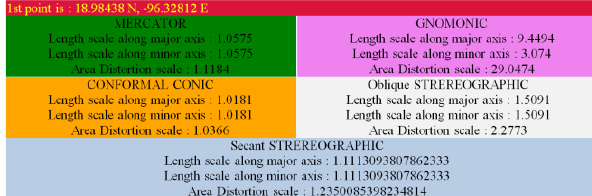
Figure 6. Example screenshot from the report section of the visualizer.